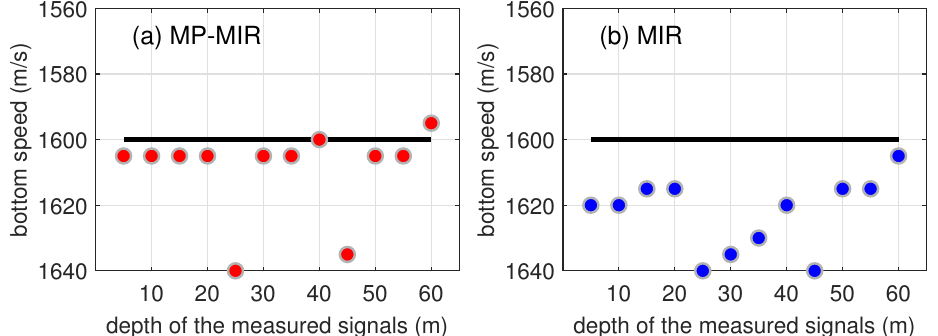
Figure 5. Bottom speed estimates of 12 “measured” signals. Black horizontal lines represent the true bottom speed of 1600